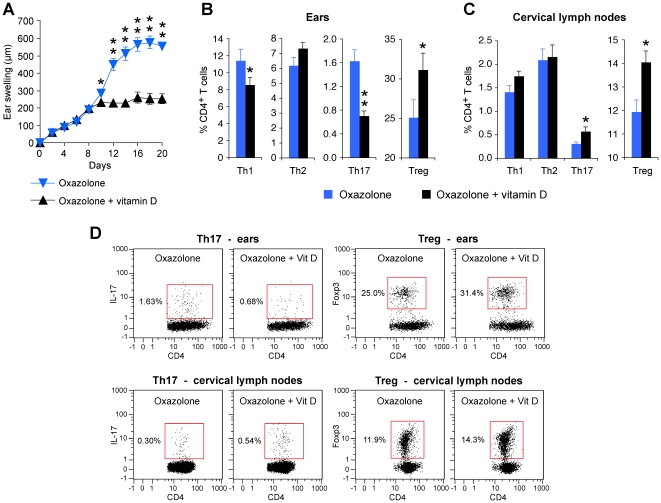
Induction of Treg cells by vitamin D reduces the inflammatory response to oxazolone and decreases the numbers of Th17 cells in the skin of Pglyrp3
−/− mice.(A) Vitamin D applied to the skin of Pglyrp3
−/− mice together with oxazolone reduces ear swelling compared to Pglyrp3
−/− mice similarly treated with oxazolone alone. (B–D) Vitamin D applied to the skin of Pglyrp3
−/− mice together with oxazolone increases the percentages of Treg cells in the ears and cervical lymph nodes and reduces the percentages of Th17 cells in the ears compared to the application of oxazolone alone, measured on day 20 by flow cytometry. Means ± SEM of 8 mice/group (A–C; *, P<0.05; **, P<0.005; oxazolone versus oxazolone + vitamin D) or representative dot plots (D) are shown.